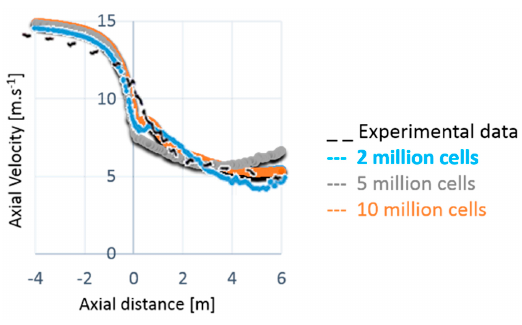
Figure A1. Mesh Sensitivity Study.